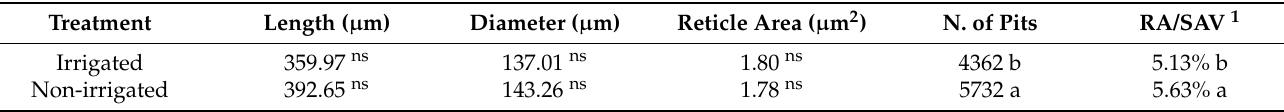
Figure 3. Field emission scanning electron microscopy of the vessel of Khaya grandifoliola . ( a ) Full ‐ length xylem vessel; ( b , c ) details of secondary wall thickening.